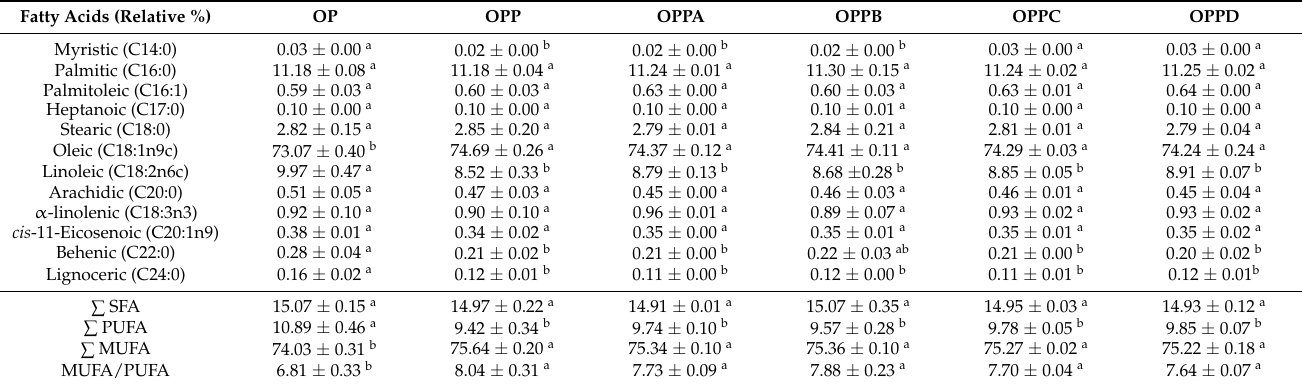
Table 3. Fatty acids profile of olive pomace